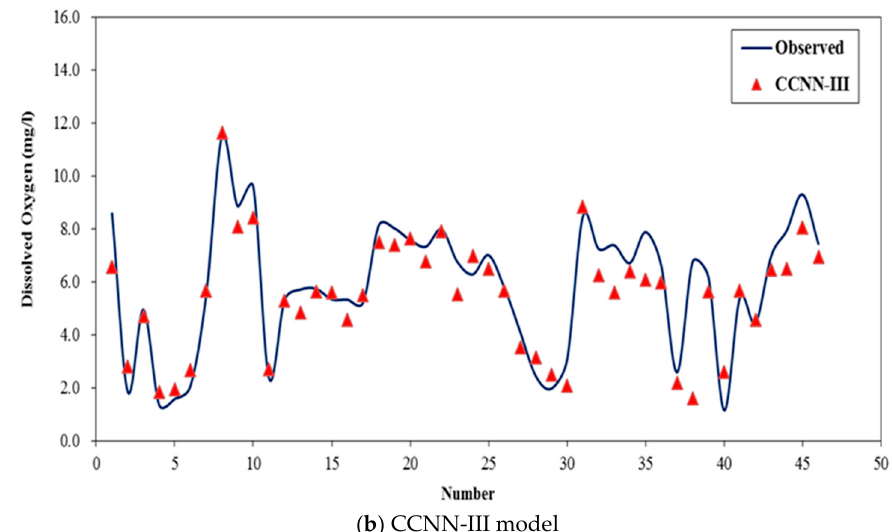
Figure 6. Comparison of observed and predicted DO values using standalone models for the testing phase.